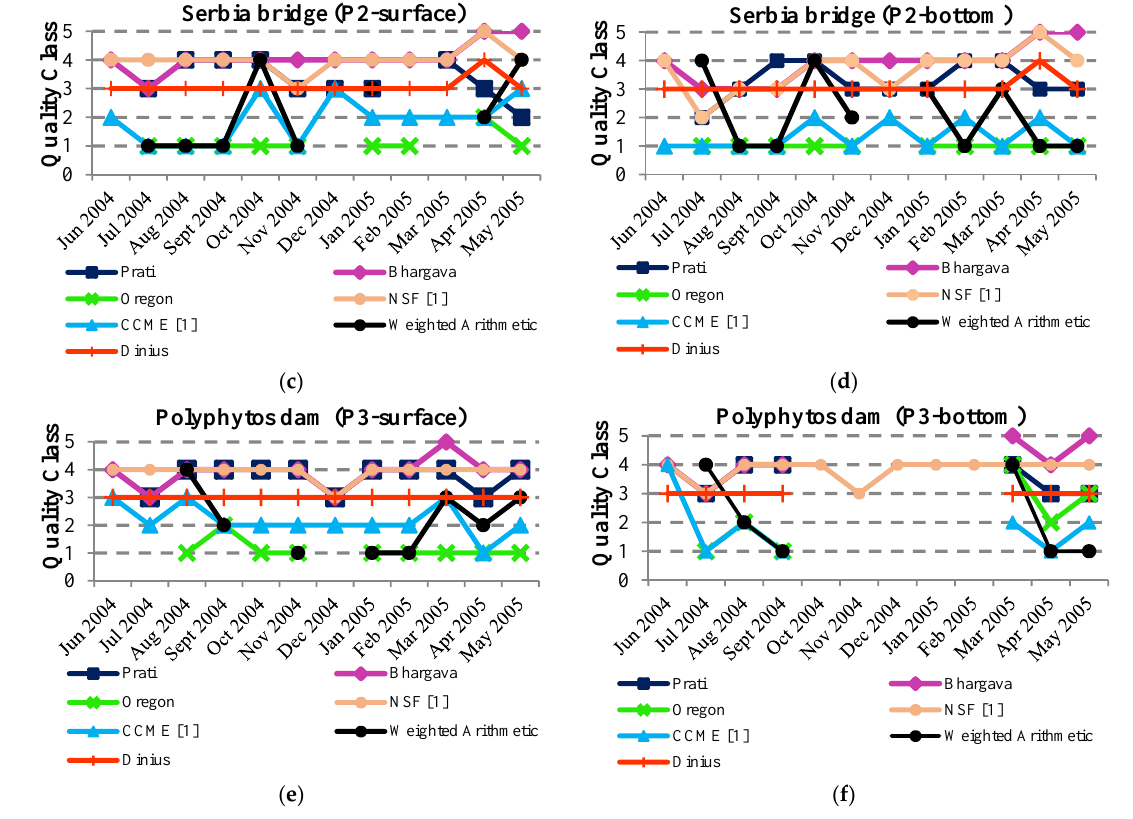
Figure 2. Variation of the quality class in Polyphytos reservoir according to each WQI applied at each of the three stations and two depths: ( a ) monitoring station P1 ‐ surface; ( b ) monitoring station P1 ‐ bottom; ( c ) monitoring station P2 ‐ surface; ( d ) monitoring station P2 ‐ bottom; ( e ) monitoring station P3 ‐ surface; ( f ) monitoring station P3 ‐ bottom. Table 2. Final classification of Polyphytos reservoir based on the worst quality scenario for each WQI